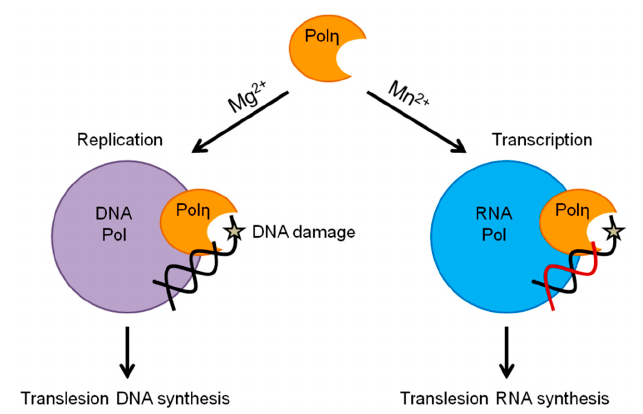
Figure 6. Proposed function of the selective metal cation-dependent activities of yeast Pol η . The arrows next to Mg 2 + and Mn 2 + symbolize specific strong enhancement of the DNA or RNA synthetic activities of Pol η , respectively.